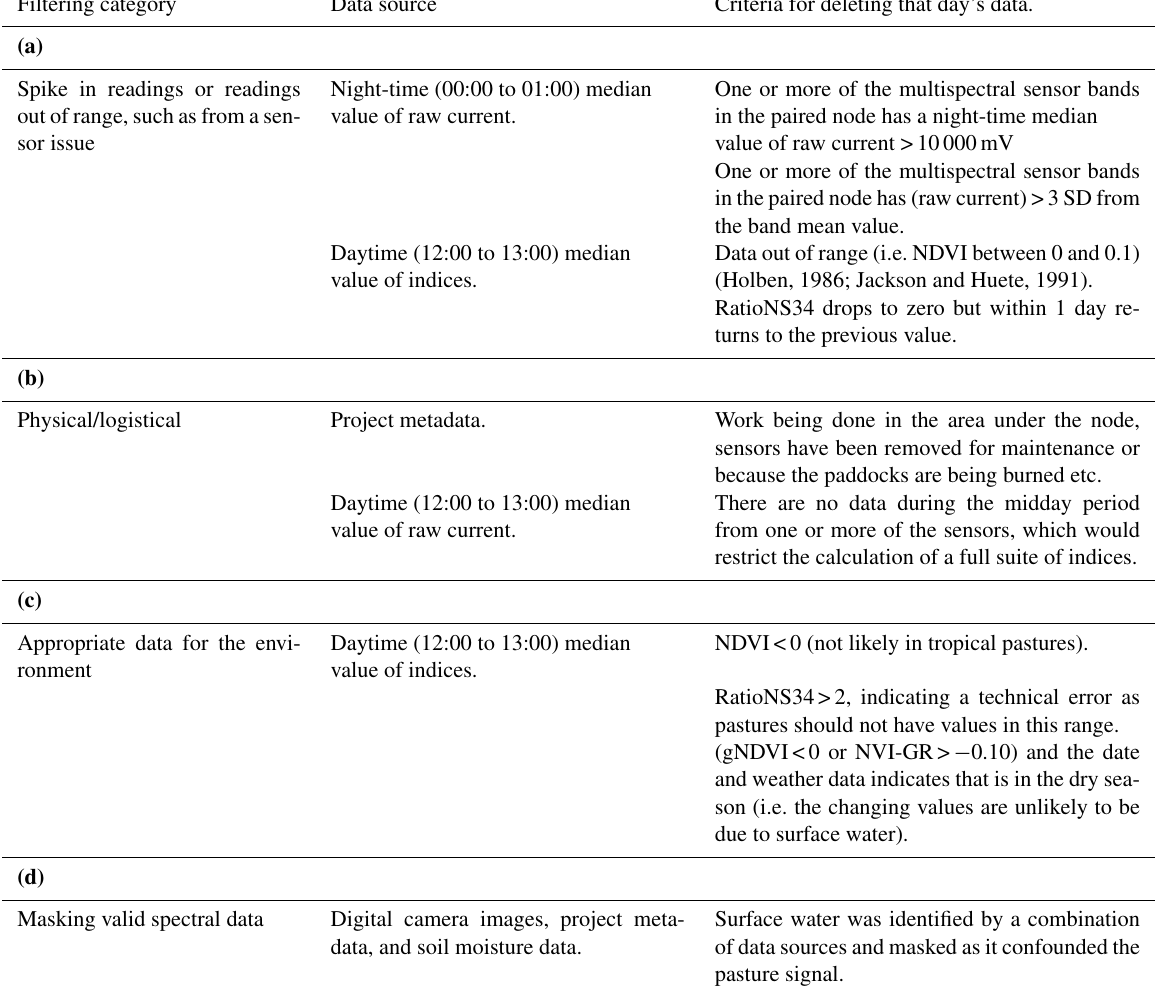
Table 2. Criteria for filtering multispectral data for a day. Daily data were removed if they met any one of the following criteria. Filtering category Data source Criteria for deleting that day’s